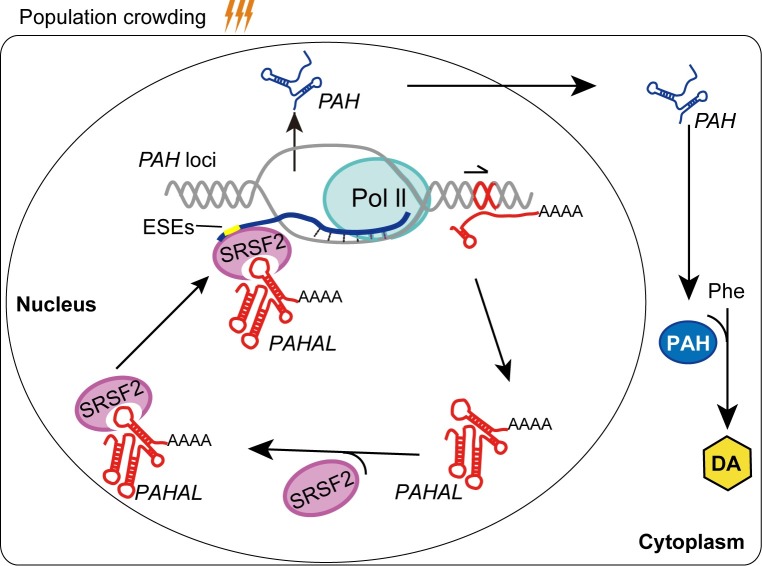
Working model for the feedback activation of PAH via PAHAL–SRSF2 interaction in the DA metabolic pathway.The sense nuclear lncRNA PAHAL is transcribed from the exon–intron region of PAH gene locus cued by population crowding. PAHAL then binds with SRSF2 at its 3′ end to form a RNA–protein complex. PAHAL guides the PAHAL–SRSF2 complex to bind with the ESE elements of the nascent PAH RNA and activates the PAH transcription. PAH catalyses phenylalanine into DA. The red genomic region in the PAH loci represents the PAHAL emanative fragment. The half arrowhead indicates the transcriptional direction of PAHAL.